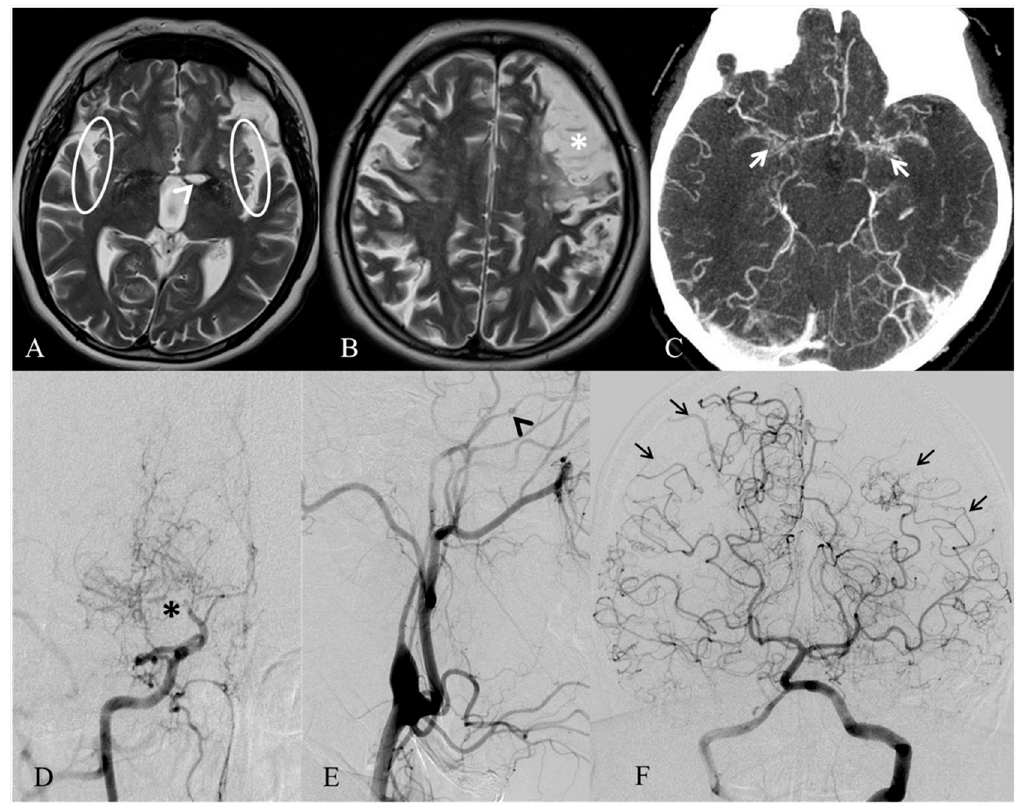
Figure 1. MRI and angiographic images of MA of our case. Axial T2-weighted MRI ( A , B ) exhibits only a few vascular voids in the Sylvian fissures (white circles), due to a reduced flow in both the middle cerebral arteries. A well-demarcated ischemic stroke in the left nucleo-capsular region (white arrowhead) and an infarct involving the left frontal lobe (white asterisk) are also noticeable. Axial angio-CT ( C ) shows proliferation and enlargement of the lenticulostriate arteries (white arrows) in the basal ganglia. Right and left common carotid arteries’ angiograms ( D – E ) demonstrate a distal stenosis of the right internal carotid artery (black asterisk), with development of prominent collateral vessels, giving the characteristic puff of smoke appearance of moyamoya disease, and an occlusion of the left internal carotid artery, distally to the ophthalmic artery (black arrowhead). Left vertebral artery angiogram ( F ) indicates leptomeningeal cortical anastomosis from both the posterior cerebral arteries to the parietal and temporal lobes (black arrows).